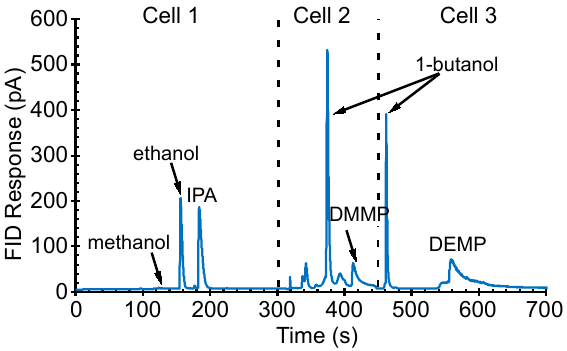
Figure 9. The PCA3mv chromatogram of 30 min sampling of 1 ppm of alcohols and phosphonate esters. Methanol, ethanol, and IPA were separated in Cell 1, 1-butanol and DMMP were separated in Cell 2, and 1-butanol and DEMP were separated in Cell 3.